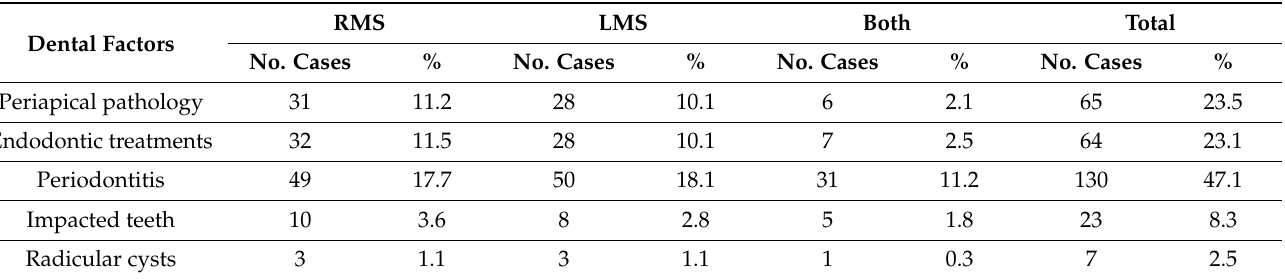
Table 1. Distribution of dental factors found in the right and left maxillary sinus by number of cases and percentages.